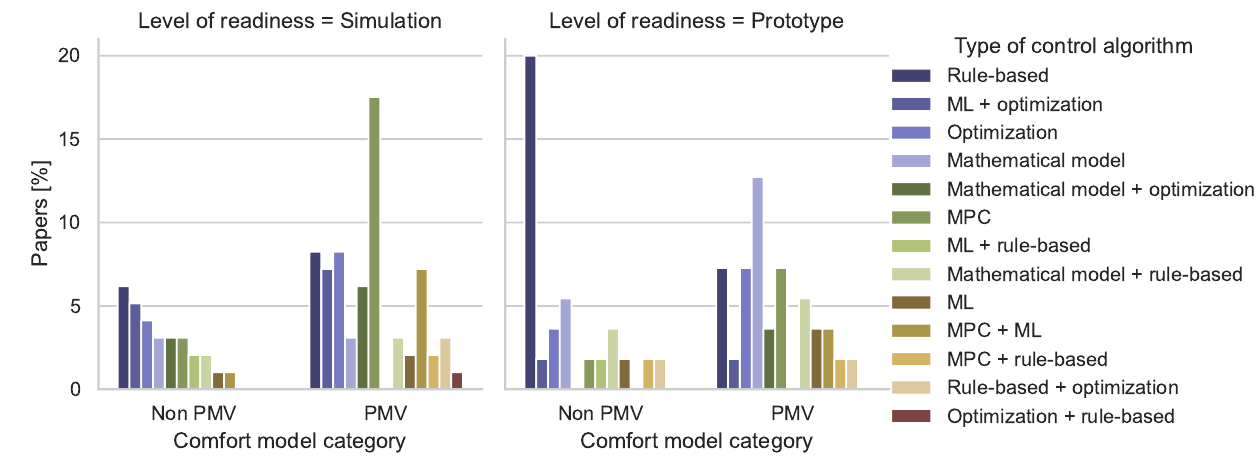
Figure 13. Thermal comfort model category at varying control algorithms and levels of readiness. Percentages are relative to the total number of papers considered in either chart (i.e., with the specific level of readiness).